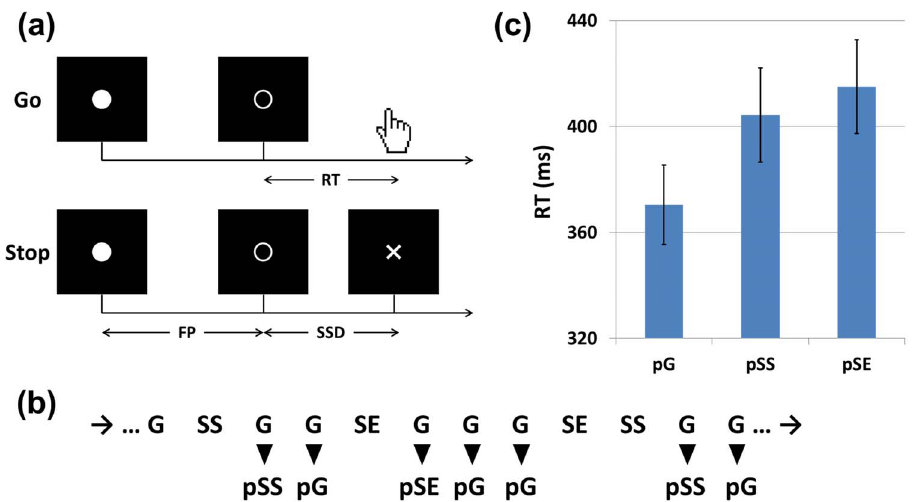
Figure 1. Stop signal task and trial structure. (a) Stop signal paradigm. In ‘‘go’’ trials ( , 75%), observers responded to the go signal (a circle), and in ‘‘stop’’ trials ( , 25%), they had to withhold the response when they saw the stop signal (an X). In both trials, the go signal appeared after a randomized time interval between 1 to 3 second (the fore-period or FP, uniform distribution) following the appearance of the fixation point. The stop signal followed the go signal by a time delay—the stop signal delay (SSD). The SSD was updated according to a staircase procedure, whereby it increased and decreased by 64 msec following a stop success and stop error trial, respectively. We distinguished go success (G: 98.4 6 1.7%, mean 6 SD) and go error (F: 1.6%), and stop success (SS: 48.6 6 2.3%) and stop error (SE: 51.4%) trials during the task. (b) An example of trial sequence. Go successes were further distinguished by their preceding trial; thus, G trials preceded by a G, SS, and SE trial were indicated by pG, pSS, and pSE trials, respectively. Depending on whether they increased or did not increase in RT, compared to the mean RT of all preceding pG trials, pSS and pSE trials were further grouped into pSSi and pSSni, and pSEi and pSEni trials, respectively (not shown here; see Methods). (c) Both pSS and pSE trials showed prolonged RT, compared to pG trials, whereas pSS and pSE trials did not differ in RT. Data bars show median RT (mean 6 S.E.) across all 16